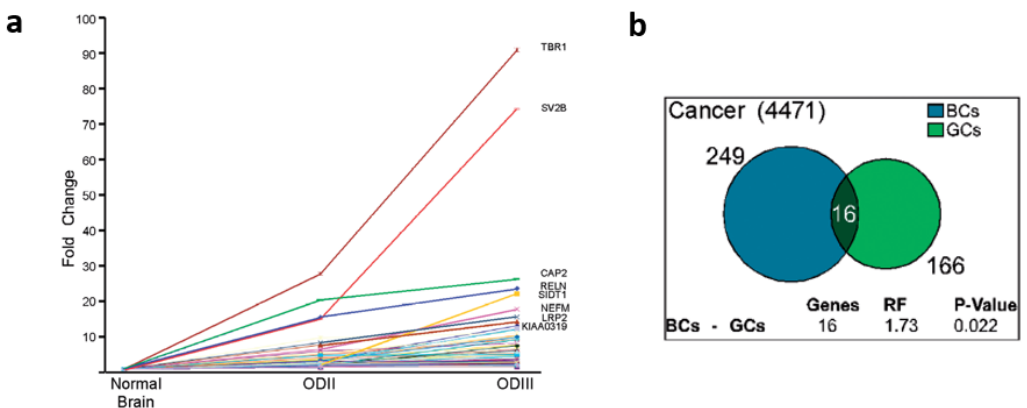
Figure 4. Activation of LSS in cancer: ( a ) Correlation between the level of activation of latent splicing and the severity of OD. The graph depicts fold changes in the level of latent splicing in 125 gene transcripts whose latent splicing expression increased from normal cells to ODII and further increased in ODIII. Names of the top-scoring gene transcripts are indicated. ( b ) Overlap between activated LSSs in breast cancer (BC) MCF-7 cells, and in glial tumors (GC, glioma cancer). Adapted from ref. [31].